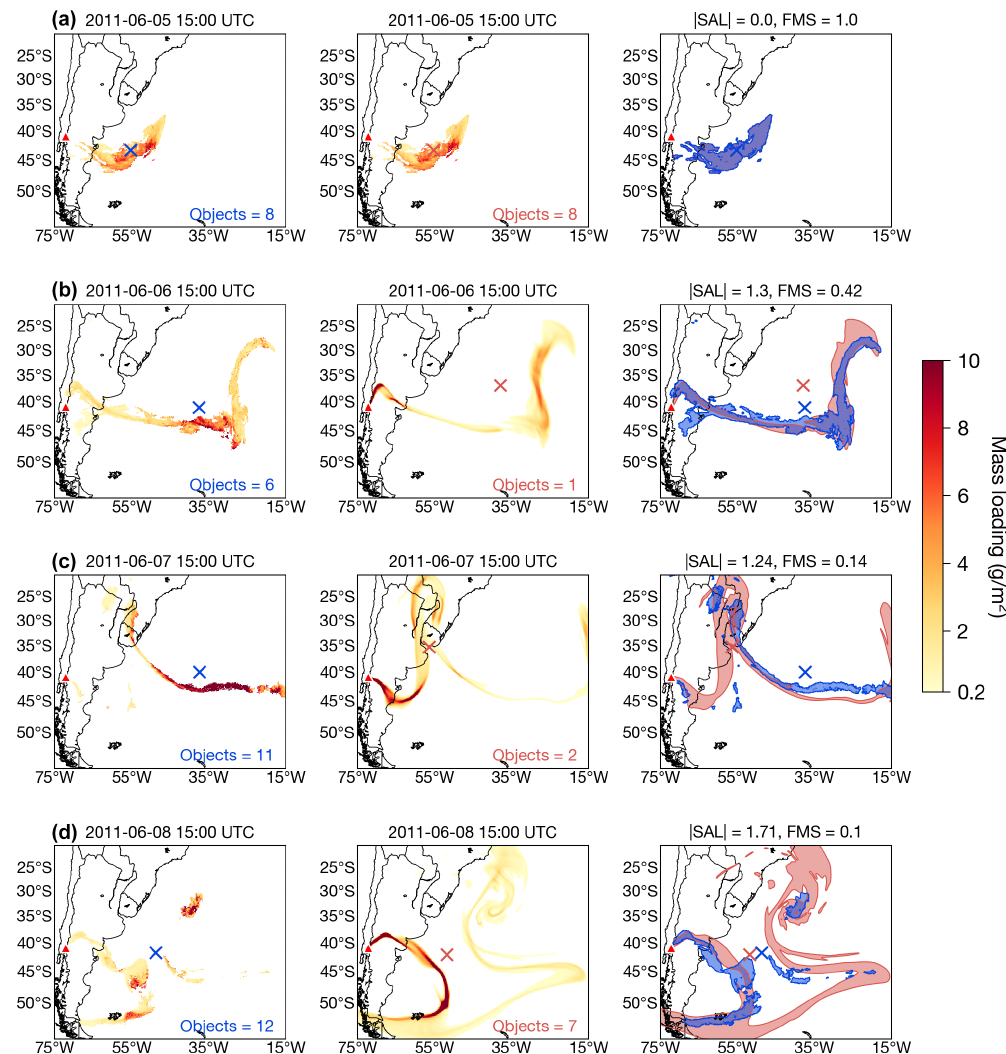
Figure 1. Puyehue-2011 test validation results for fine ash mass loading using SEVIRI retrievals on (a) 5 June 2011 at 15:00UTC (data insertion time), (b) 6 June 2011 at 15:00UTC, (c) 7 June 2011 at 15:00UTC and (d) 8 June 2011 at 15:00UTC. Left panels show satellite retrievals with 0.2gm − 2 contour in blue and centre of mass indicated with an “x”. Middle panels show FALL3D fine ash mass loading model simulation (0.2gm − 2 contour in red). Right panels show spatial overlap of model (shaded in red) vs. observed (shaded in blue) fields with validation metrics annotated (see Sect. 4 for details). A full animation of the data insertion simulations is available in the Video Supplement 1 (Prata et al.,